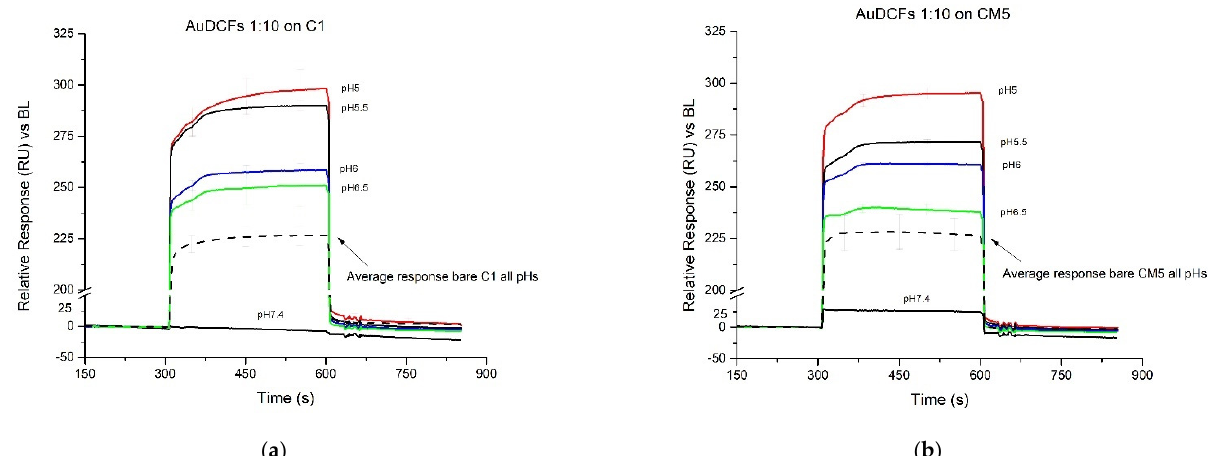
Figure 6. SPR sensorgrams of different pH solution injections on Au-DCF 1:10 covalently immobilized on: ( a ) C1 chip and ( b ) CM5 chip. The black dotted line shows the average response of the blank channel on each chip, to all pH solutions.